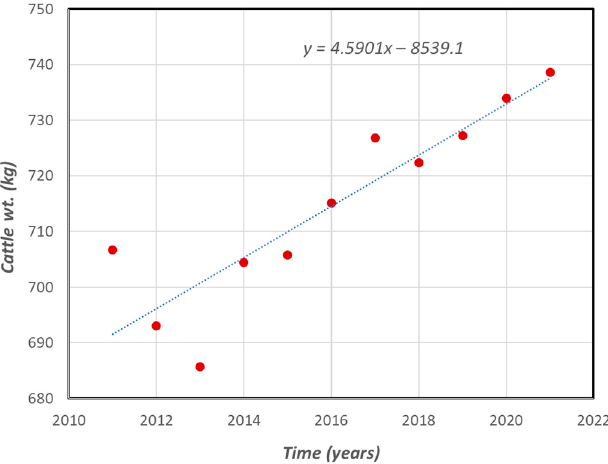
Figure 3. Trend of average weight of live beef cattle produced in Korea since 2011 (source: KOSIS [44]).